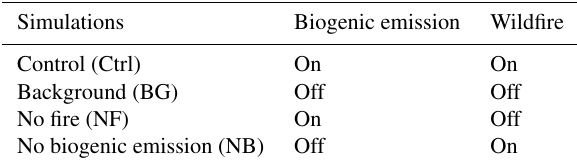
Table 1. Configurations of GEOS-Chem nested simulations in this